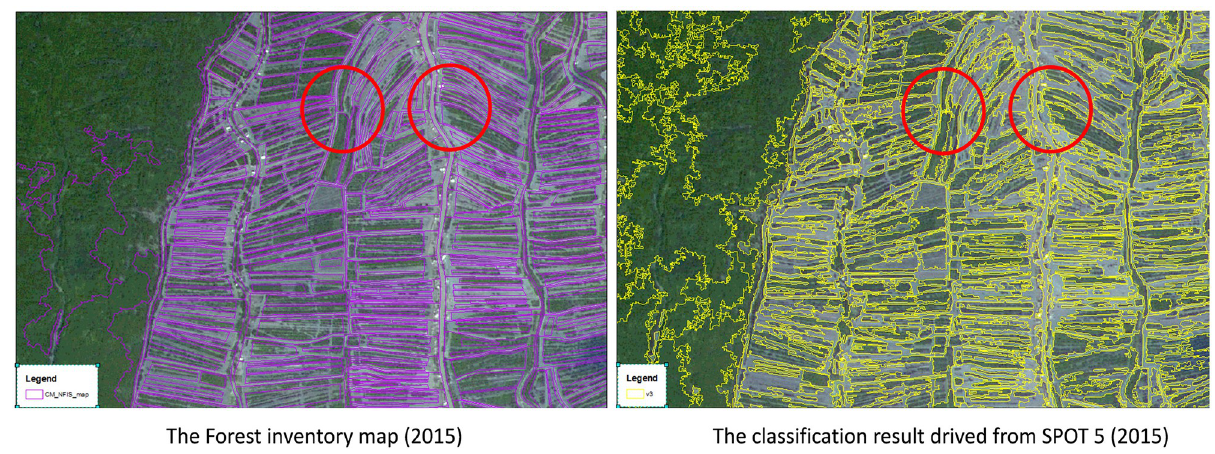
Fig 11. The visual comparison between the results of the image classification and the Forest inventory maps (republished satellite data under a CC BY license, with permission from the Department of Remote Sensing, Ministry of Natural Resources and Environment of Vietnam, original copyright [1995, 2004, 2015]).